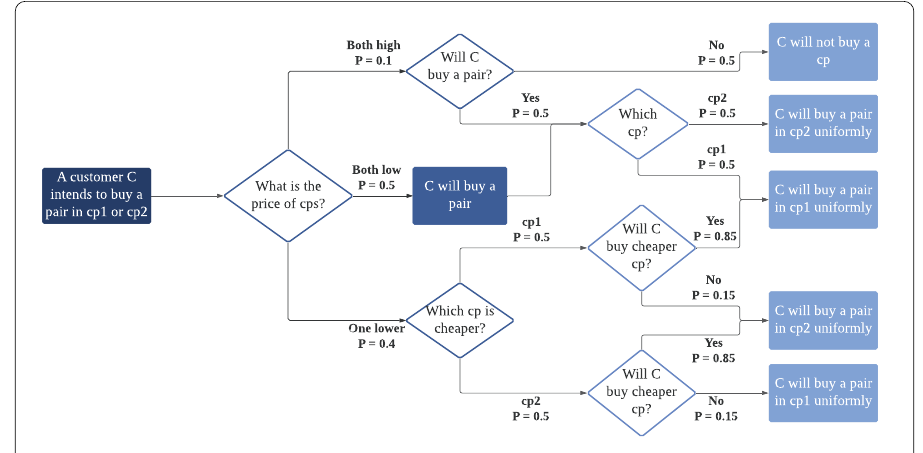
Figure 4 Illustration of how each customer chooses a complementary pair (cp), where cp1 and cp2 correspond to the hot-dog -and- hot-dog-bun and taco-shell -and- taco-seasoning complementary pairs,